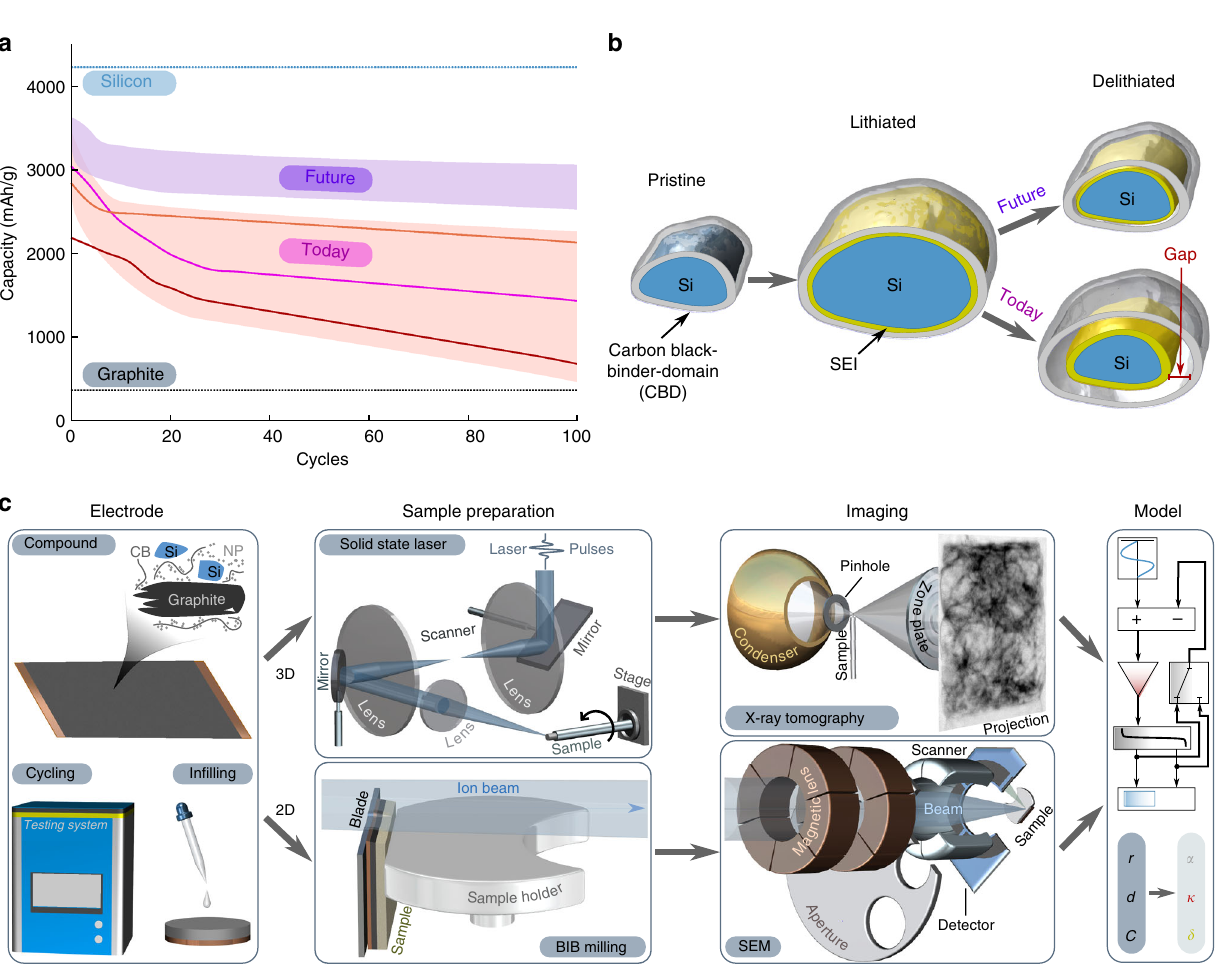
Fig. 1 Motivation and methods. a Comparison of the speci fi c charge capacity of graphite (gray line) and silicon (light blue line) electrodes. The red shaded area shows example performances of today ’ s graphite-silicon compound electrodes leaving space for improvement in the future (purple shaded area). b Illustration of a major degradation mechanism in silicon electrodes. Upon lithiation of silicon, a solid electrolyte interphase (SEI) fi lm (yellow) forms on the silicon particle surface and the carbon black-binder domain (light gray) is pushed outwards. Upon delithiation, the silicon particle shrinks, thereby detaching from the carbon black-binder domain. The arising gap (red) electrically isolates the silicon particle, thereby leading to rapid capacity fade. c Schematic of experimental steps and methods used in this work. From left to right: silicon-graphite mixed electrode sheets are fabricated, electrochemically cycled, and in fi ltrated with epoxy resins. For 3D transmission X-ray tomographic microscopy imaging the in fi ltrated samples are milled to the required size using a pulsed solid-state laser, while for 2D scanning electron microscopy imaging cross-sections of the electrodes are prepared using Broad Ion Beam milling. The combined 2D and 3D data are quantitatively analyzed and used to develop a predictive model that links the mechanical properties of the composite electrode ( α ; κ ) and SEI growth rate ( δ ) for a particle of radius r to the detachment distance d and the capacity fade indicated by the dotted lines, which are included as a guide to the eye.